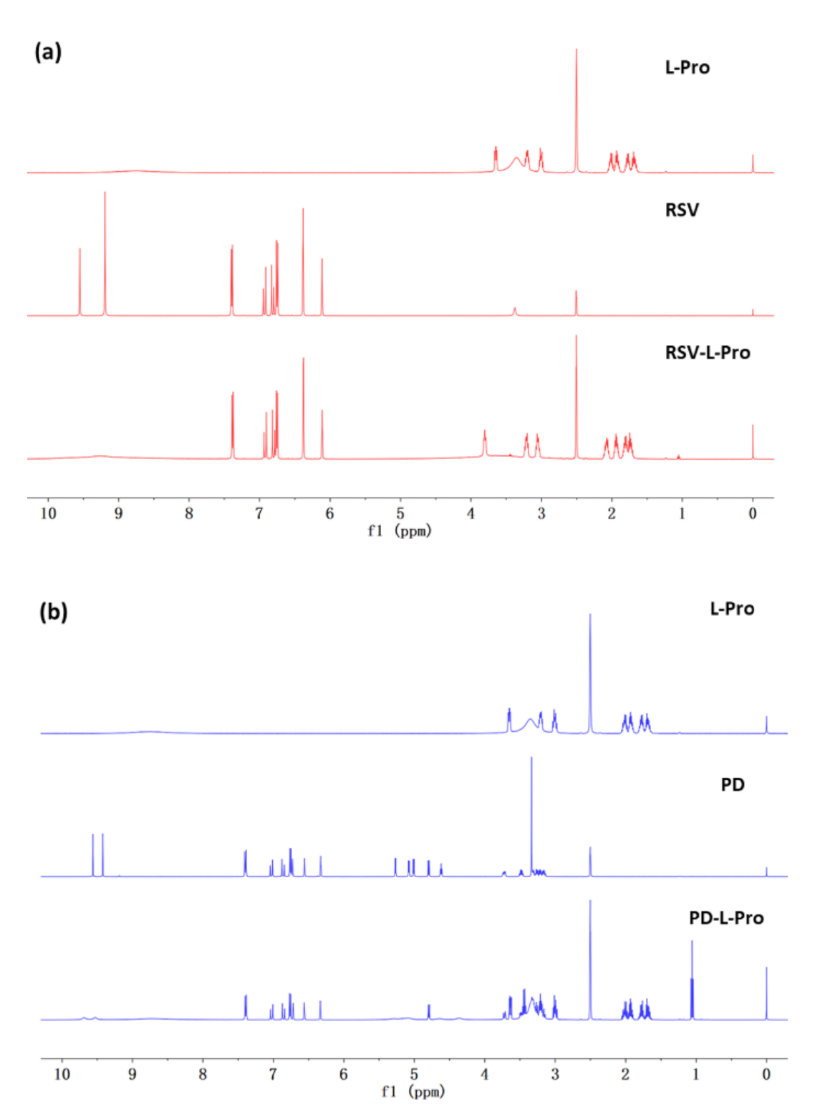
Figure 3. The 1 H NMR spectra of L-Pro, RSV, and PD, as well as for their respective co-crystals RSV-L-Pro ( a ) and PD-L-Pro ( b